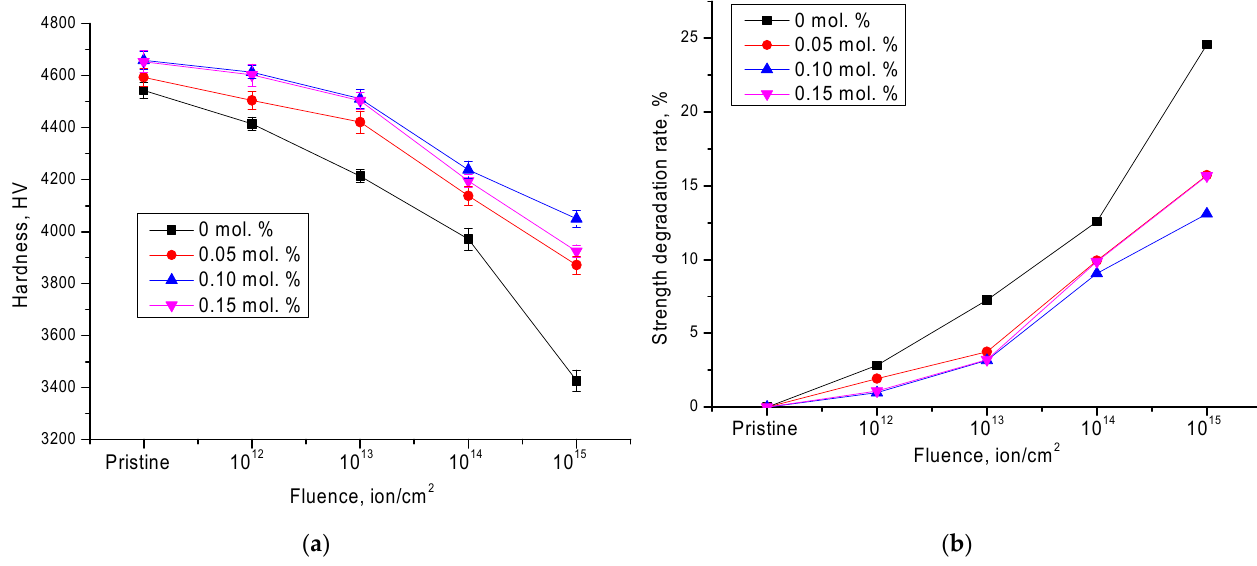
Figure 5. ( a ) Dependence of hardness change on irradiation fluence; ( b ) dependence of change in degree of hardness degradation on irradiation fluence.